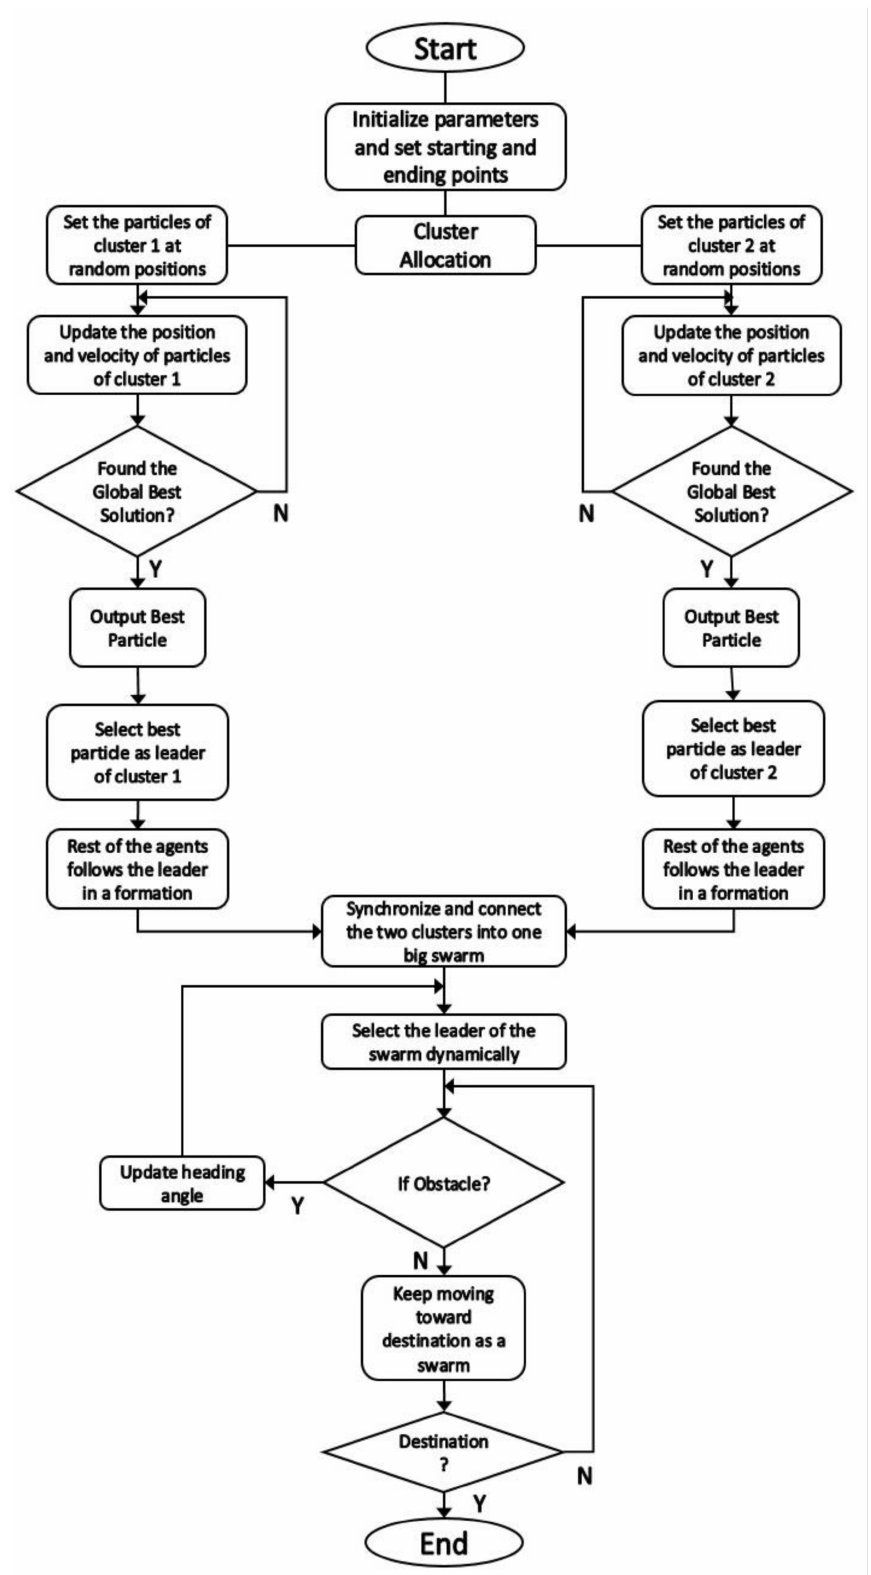
Figure 5. Flowchart of the Proposed